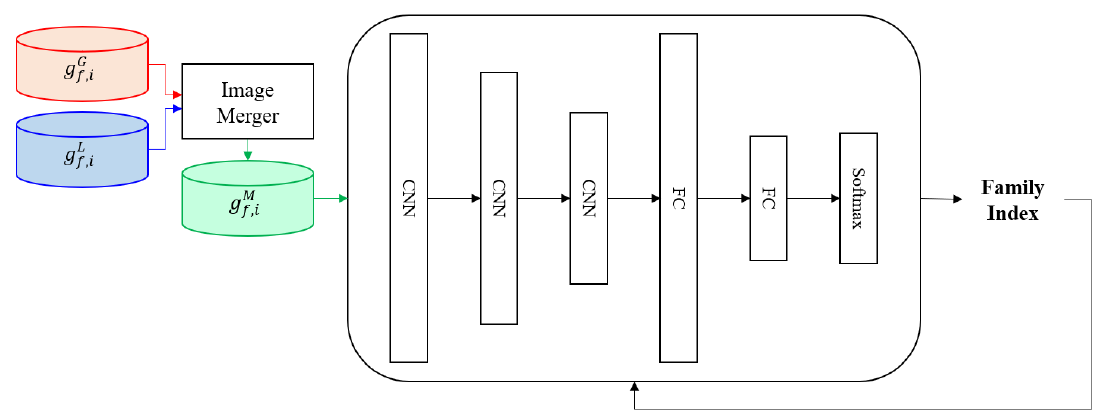
Figure 5. Convolutional neural network (CNN) training process.